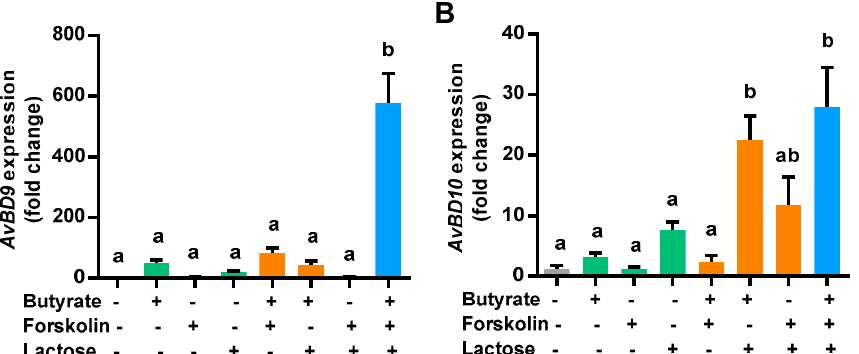
Figure 2. Induction of host defense peptide gene expression in chicken jejunal explants by butyrate, forskolin, and lactose. Chicken jejunal segments were cultured and treated in triplicate with 4 mM butyrate, 5 μ M forskolin, and 0.1 M lactose individually or in different combinations for 24 h, followed by RT-qPCR analysis of the gene expressions of AvBD9 ( A ) and AvBD10 ( B ). Results are presented as means ± SEM of 3–4 independent experiments. Means not sharing a common letter are significantly different ( p < 0.05; one-way ANOVA and post hoc Tukey’s test).